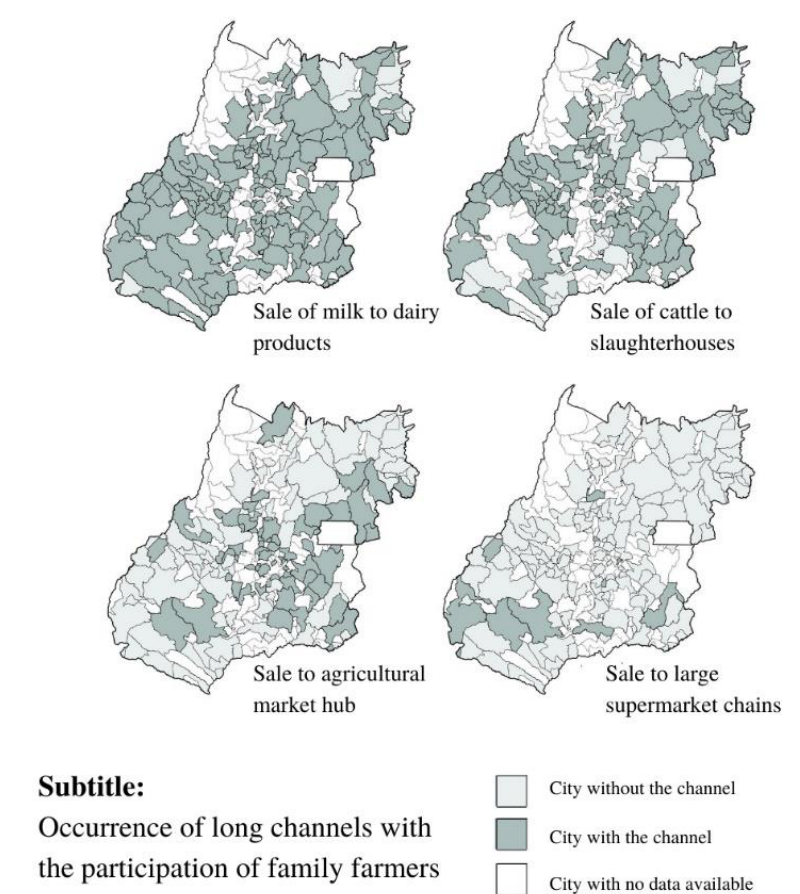
Figure 2. Presence of long sales channels with family farmers’ participation (sale of milk to dairies, sale of cattle to slaughterhouses, sales to agricultural market hubs, and sales to large supermarket chains).